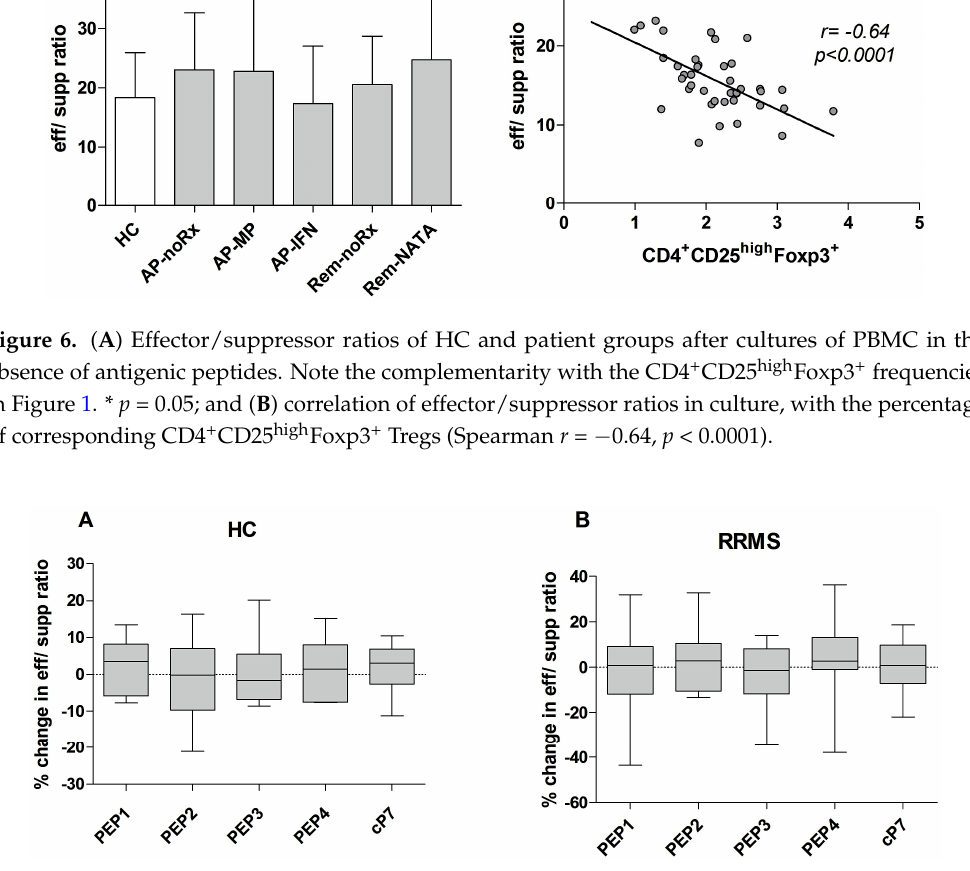
Figure 7. Mean changes in effector/suppressor ratios in HC ( A ) and RRMS patients ( B ), after culture with the antigenic peptides (PEP1-4, cP7) (whiskers are min to max). When the percentages of co-cultures with a suppressive change in effector/suppressor ratio were calculated, no statistical differences between patient groups and HC were found, with the exception of the Rem-noRx patient group that showed a more than two-fold higher percentage of suppressive cultures compared to the other patient groups and HC (Figure 8).